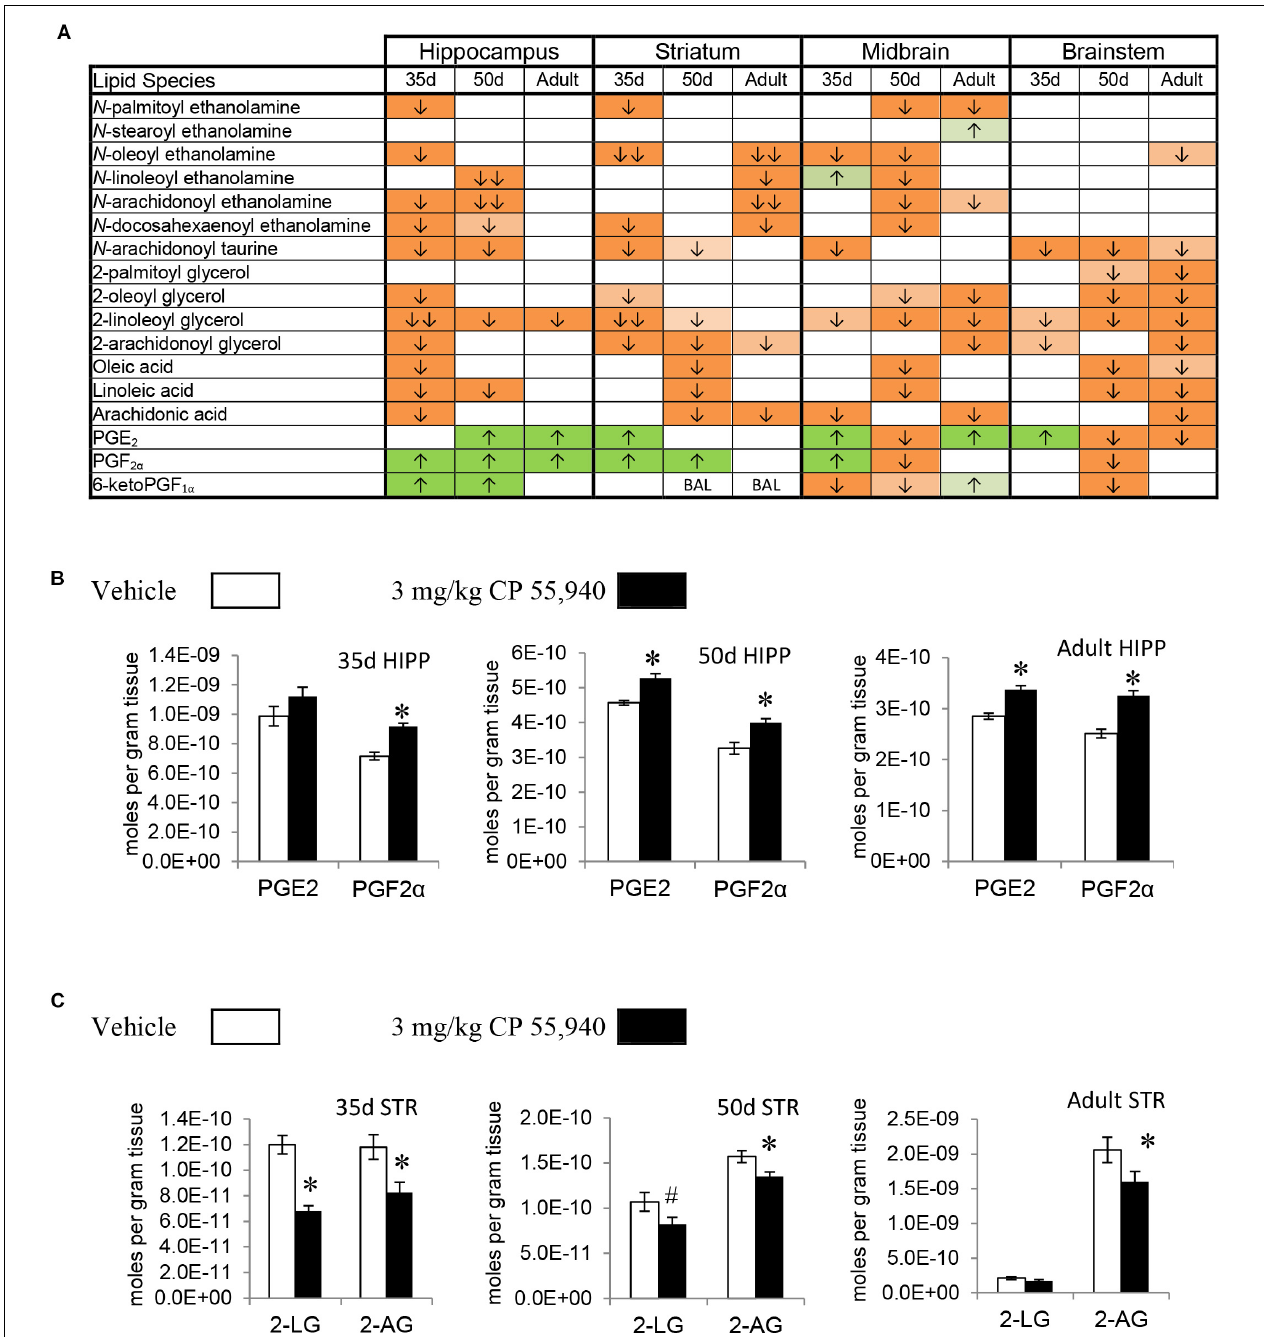
FIGURE 2 | Effects of systemic 3 mg/kg CP 55,940 (CP) on levels of targeted lipids 2 h after injection in the post-natal day (PND) 35, PND 50, and adult CD1 female mouse hippocampus, striatum, midbrain, and brainstem. (A) Cells with shaded arrows indicate a change for that lipid in the CP-exposed brain area relative to the same vehicle-exposed area within each age group (35d = PND 35, 50d = PND 50). The arrow color indicates the direction of a significant result relative to control. Green colors represent increases, with darker green representing a significant increase of p < 0.05 and lighter green representing a trending increase of p < 0.10. Orange colors represent decreases in a lipid’s concentration, with darker orange indicating a significant decrease of p < 0.05 and light orange representing a trending decrease of p < 0.10. The number of arrows indicates the magnitude of the difference between CP and vehicle. One arrow indicates a magnitude difference of less than 1.5-fold and two arrows indicate a 1.5- to 1.99-fold change. BAL stands for “Below Analytical Limit,” whereas a blank cell indicates that there was no change in the lipid’s level due to CP. See Supplementary Figure 4 for a more detailed description of analysis. (B) Bar graphs showing mean levels of prostaglandin E 2 (PGE 2 ) and prostaglandin F 2 α (PGF 2 α ) in the post-natal day 35 hippocampus (35d HIPP), post-natal day 50 hippocampus (50d HIPP), and adult hippocampus (adult HIPP) 2 h after a systemic vehicle injection (open bars) or a systemic 3 mg/kg CP injection (black bars).The units on the y -axis are moles of lipid per gram of